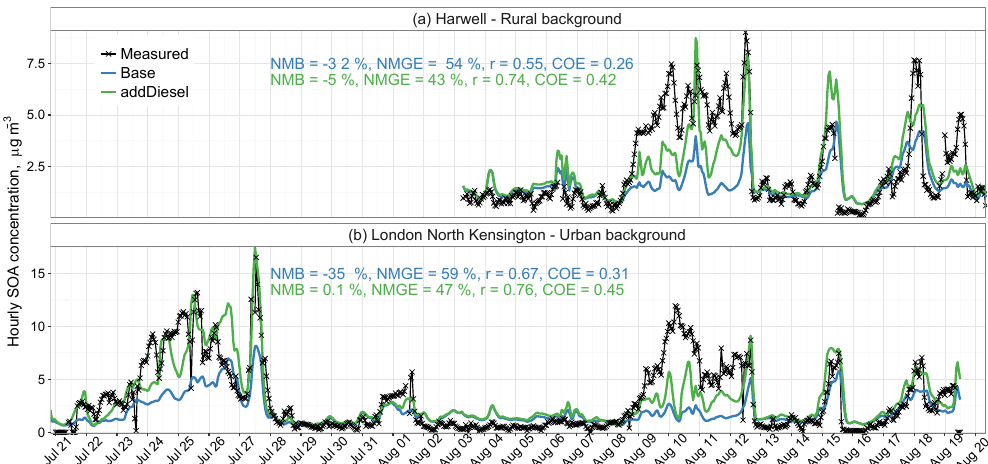
Figure 7. Time series of measured and modelled hourly average concentrations at (a) the Harwell rural background site, and (b) the London North Kensington urban background site during the summer IOP. Note the different scales on the y axes.